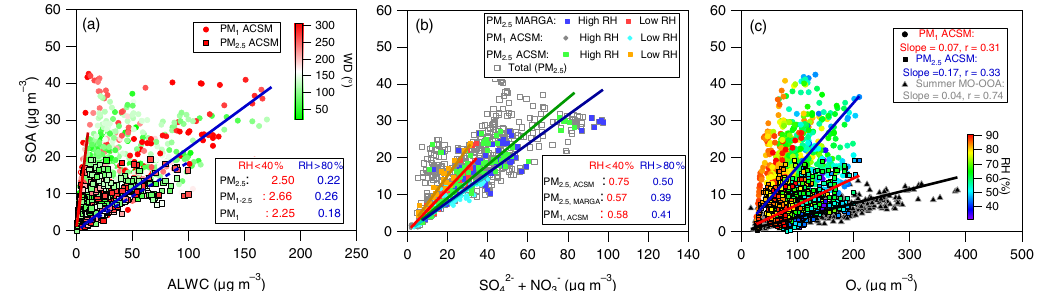
Figure 9. Correlations between (a) NR-PM 1 and NR-PM 2 . 5 SOA vs. ALWC, which is color coded by wind direction (WD), and (b) SOA vs. + NO − SO 2 − . The regression slopes at high RH (RH > 80%) and low RH (RH < 40%) levels and in different sizes (PM 1 and PM 2 . 5 ) are 4 3 also shown. (c) Relationship between the SOA for NR-PM 1 and NR-PM 2 . 5 and O x ( = O 3 + NO 2 ). The relationship between more oxidized OOA (MO-OOA) and O x at the same sampling site during summertime (August) 2013 (Zhang et al., 2017) is also shown. Note that the data points during the precipitation periods (Fig. 5b) were removed in panels (a–c)